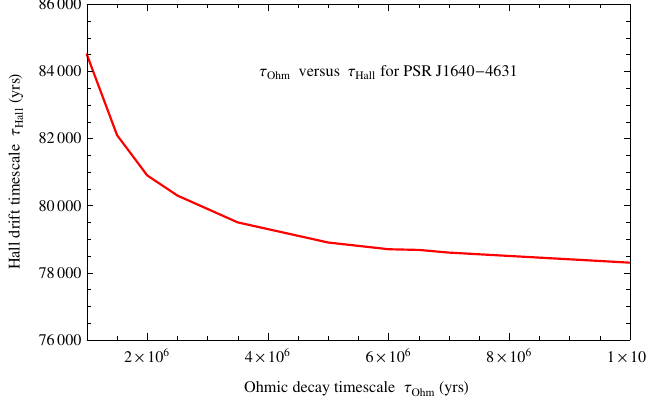
Figure 3. The relation of τ Ohm and τ Hall for PSR